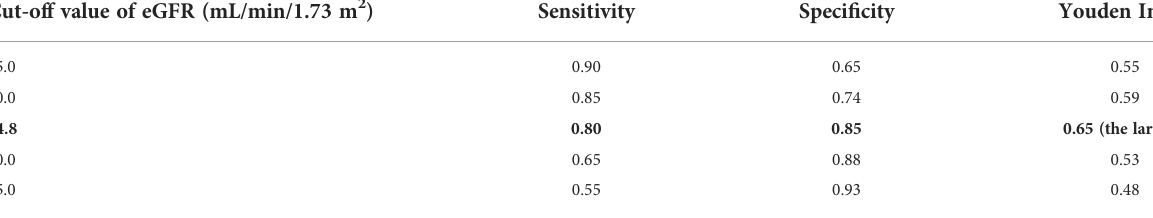
TABLE 3 The discriminative power of the predictors and the prediction model in prediting DKD. Cut-off value of eGFR (mL/min/1.73 m 2